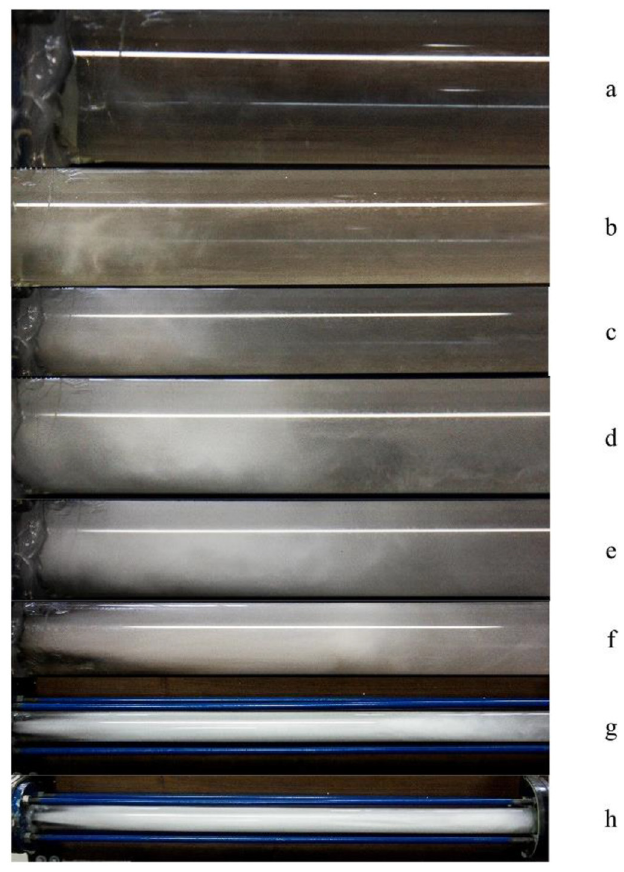
Fig. 8. The recorded photographs of the cavitation volume in the ori fi ce with b = 0.4 and in the fl ow rate of (a) 16 (b) 18 (c) 20 (d) 22 (e) 24 (f) 26 (g) 28 and (h) 28.5 m 3